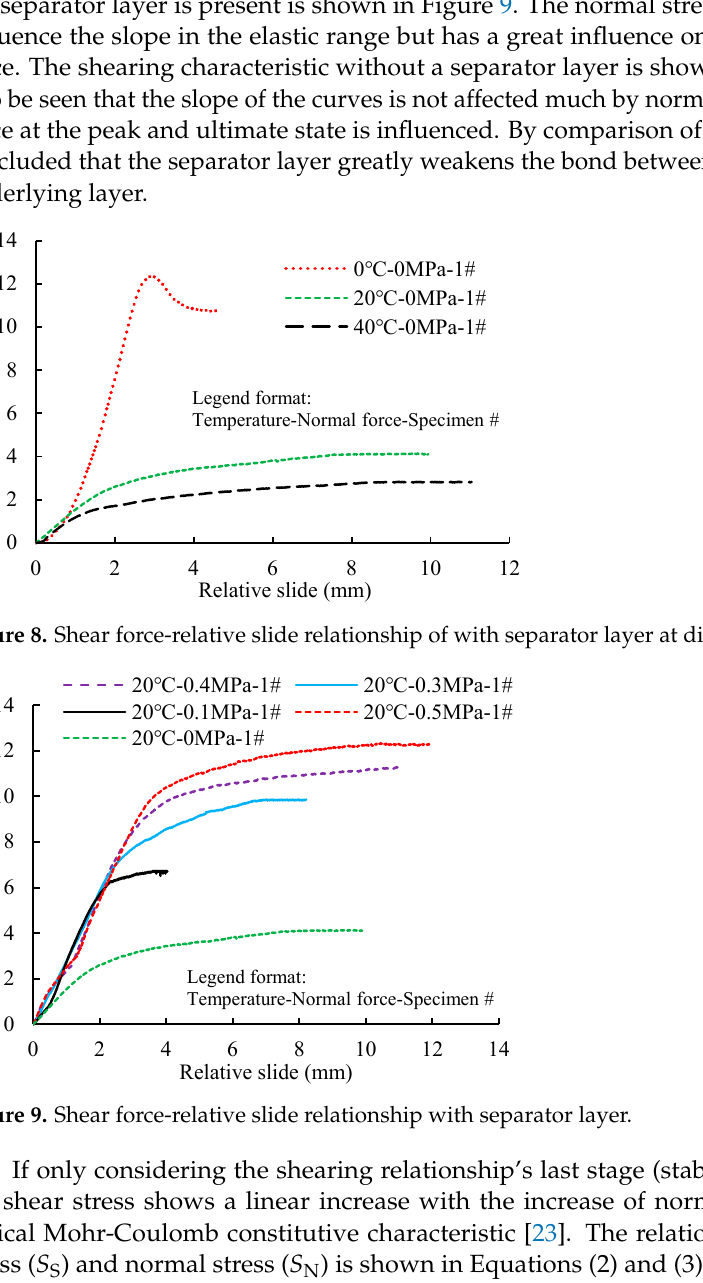
Figure 11. The interface of fracture after the shearing test. Scholars proposed hypotheses to develop the constitutional property of the interface of pavement layers, such as the non-thickness linkage type element [24] and thin layer element [25]. Though these constitutional models can realize multiple functions such as slip, non-slip, debonding, and rebonding, they involve complicated control over nodes with programs and difficult to get convergent results in common FEM software. In this study, the interlayer shearing constitutional property is simplified based on the shear force-relative slide curve so that the shearing characteristic is not oversimplified but can be integrated into the FEM in ABAQUS. The shear force-relative slide is induced